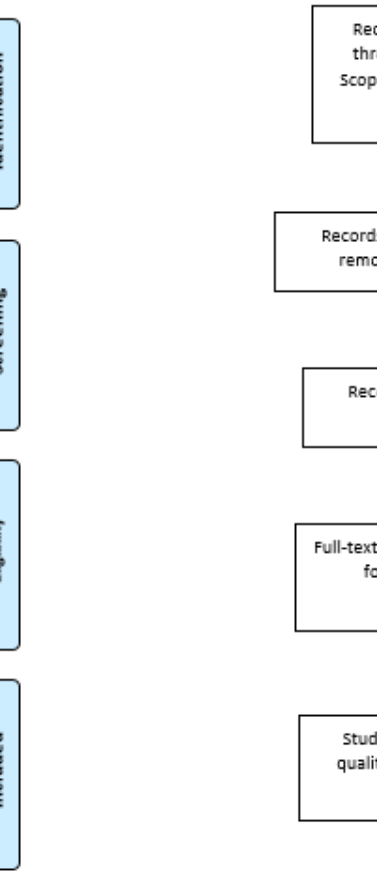
Figure 1. PRISMA Flowchart for outcomes and toxicity.